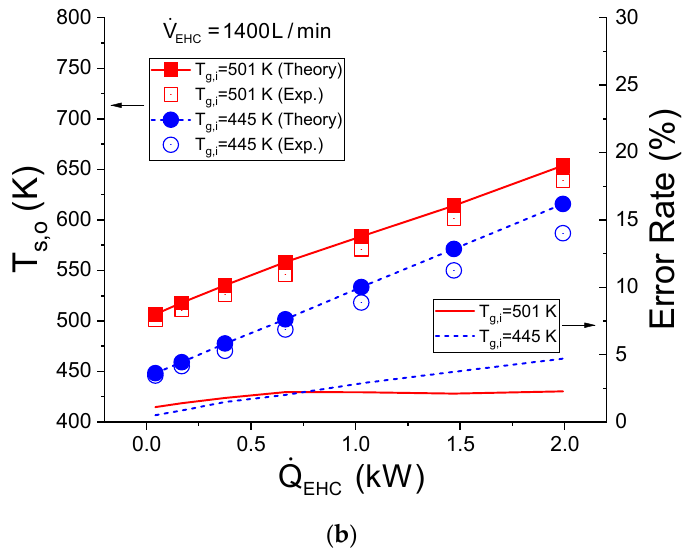
Figure 7. Comparison of predicted and measured surface temperature results at the EHC outlet ( T s , o ) under various exhaust gas flow rates ( V EHC ) and temperatures ( T g , i ), and supplied heater powers ( Q EHC ): ( a ) V EHC = 800 L/min, ( b ) V EHC = 1400 L/min ( D cell = 2.7 mm, L cell = 20 mm).